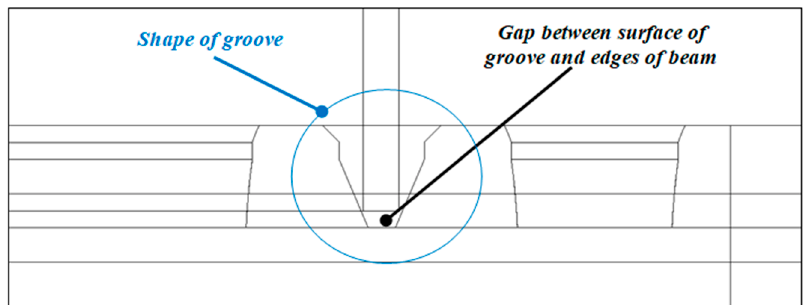
Figure 4. The view of the groove shape in relation to the column edges. Table 1. The boundary conditions of the internal surface of the plates.